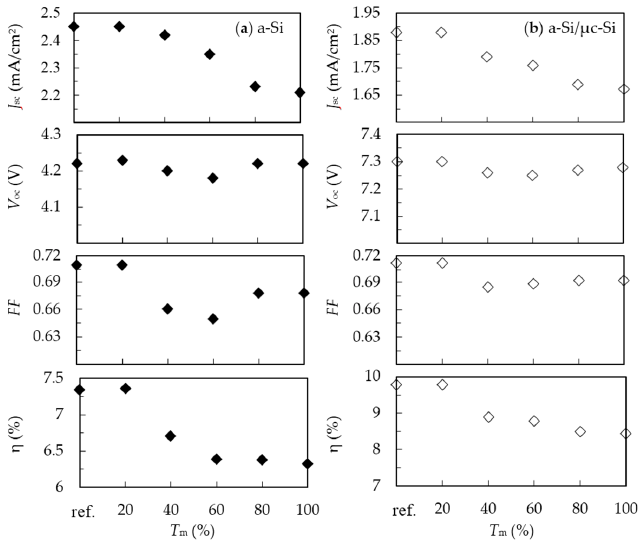
Figure 5. External parameters of ( a ) a-Si and ( b ) a-Si/µc-Si submodules with different T m values. The denoted reference is the submodule without the P4 laser process.